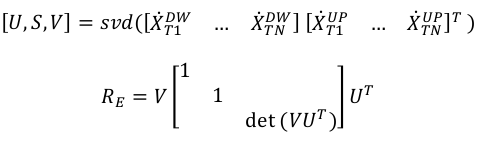
Figure 7 Example of the results of the detection of the target corners for an UP image. The image shows also the camera centre the two FoV Channels of the BPL: the Panoramic one where the target is shown and the Frontal Field (in green) covered during the